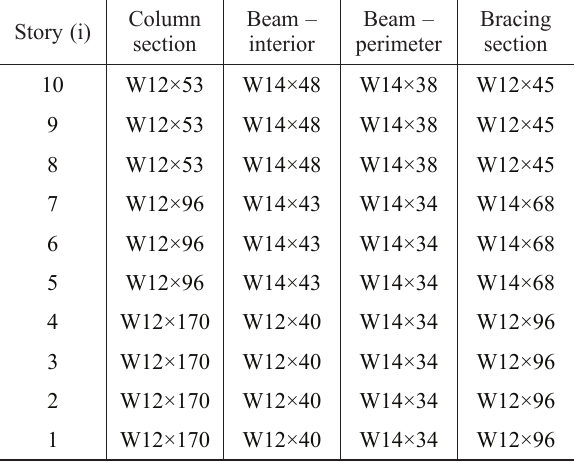
Table 5. Member data for vertically irregular – Concentrically Braced Frame (CBF) (Young, Adeli 2014a, 2014b) Story (i)